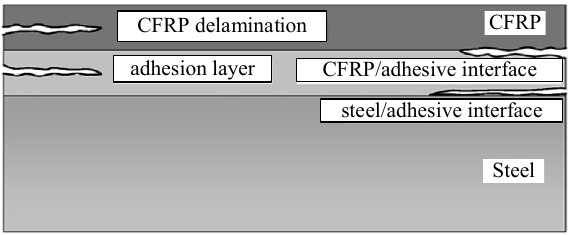
Figure 1. Form of the debonding failure for the carbon fiber reinforced polymer (CFRP) plate- strengthened steel